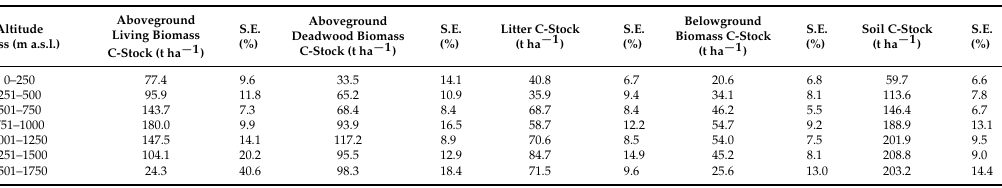
Table 4. Public land forest area within altitude classes (in metres above sea level (m a.s.l.)) and estimated C-stock per hectare (with standard errors) for different carbon pools. Altitude Class(ma.s.l.)